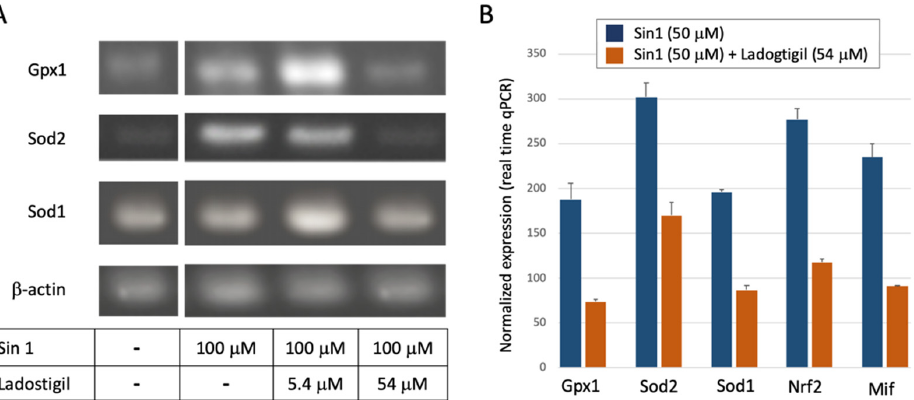
Figure 3. Measurement of expression for a set of ROS-sensitive genes by PCR. ( A ) Gel-based PCR amplification using primers listed in Table 1. ( B ) Results from real-time quantitative PCR (qPCR). The normalized expression of the listed genes in the presence of Sin1 (50 mM, blue) and the following preincubation with ladostigil (orange). Each gene is normalized to its basal level of untreated cells ( y -axis, refers to 100).